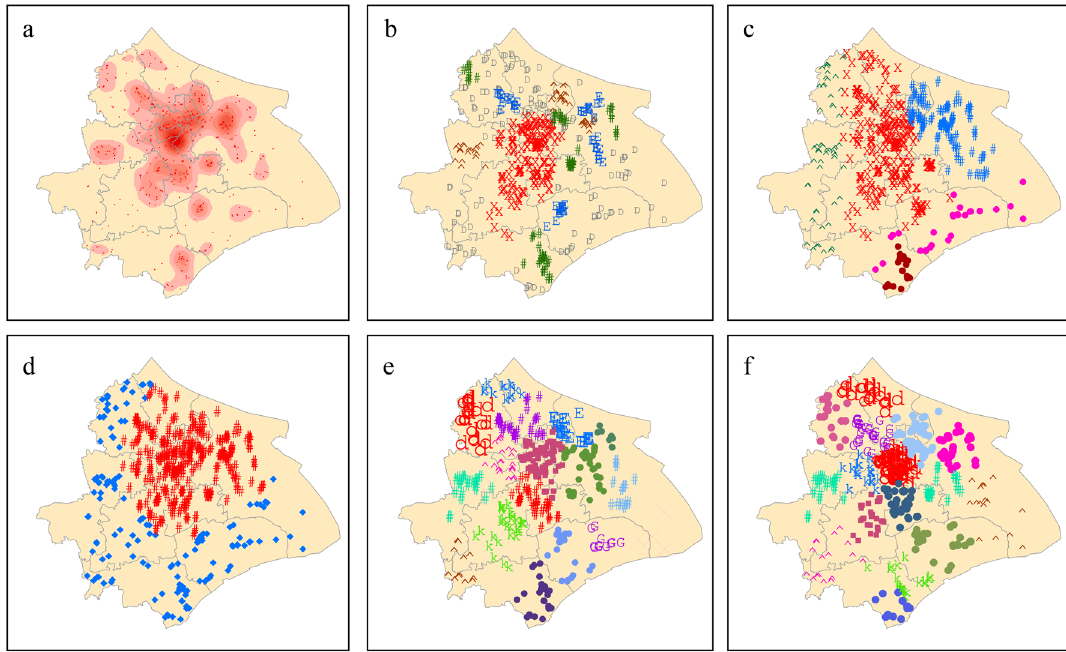
Figure 4. Identification of industrial clusters with different methods: ( a ) the result from the kernel function, ( b ) the result from EBC, ( c ) the result from GMM-EM, ( d ) the result from DBSCAN, ( e ) the result from complete- link, ( f ) the result from